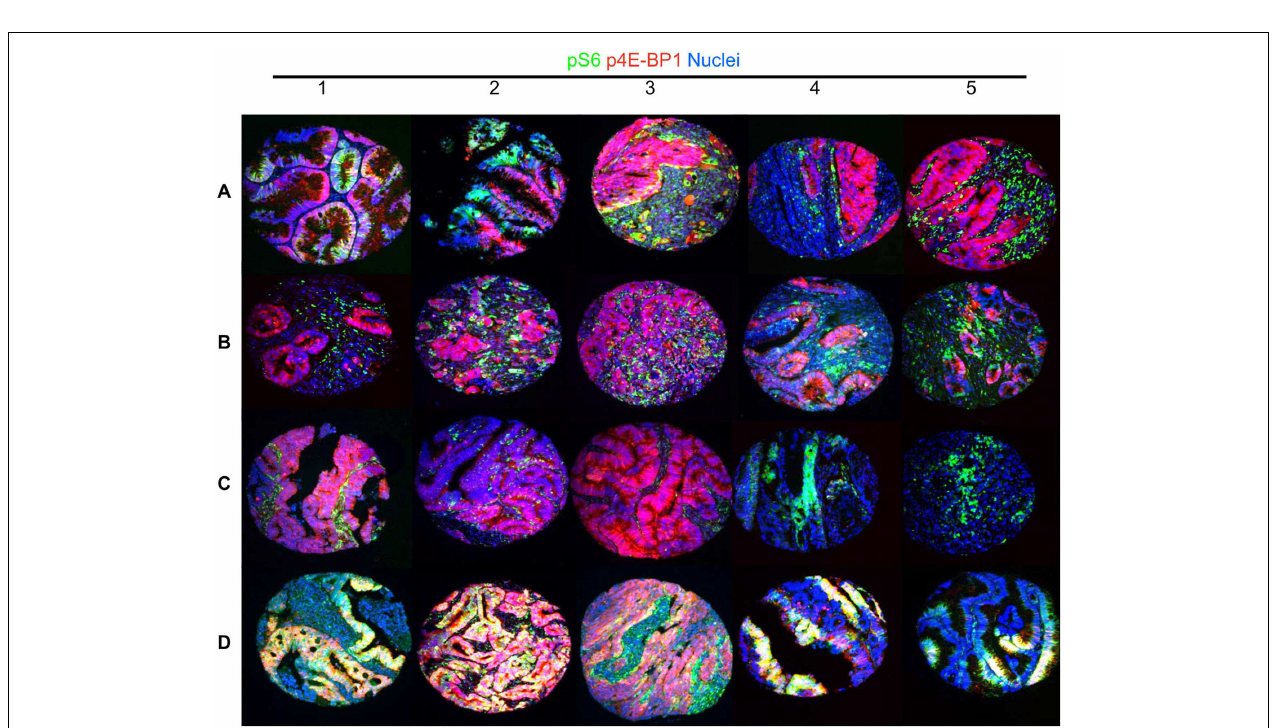
different patterns of mutually exclusive p4E-BP1 (red) and pS6 (green) signals. Many specimens exhibit a strong signal for each phosphorylation event in exclusive tumor cells (A1–A3) . Another notable pattern exhibits substantial p4E-BP1 expression in tumor cells, and a high level pS6 signal in stromal cells (A4–C2) . In addition, rare tumors exhibit high level signal in only one of the canonical mTORC1 substrates (C3–C5) , or both simultaneously (D1–D5)